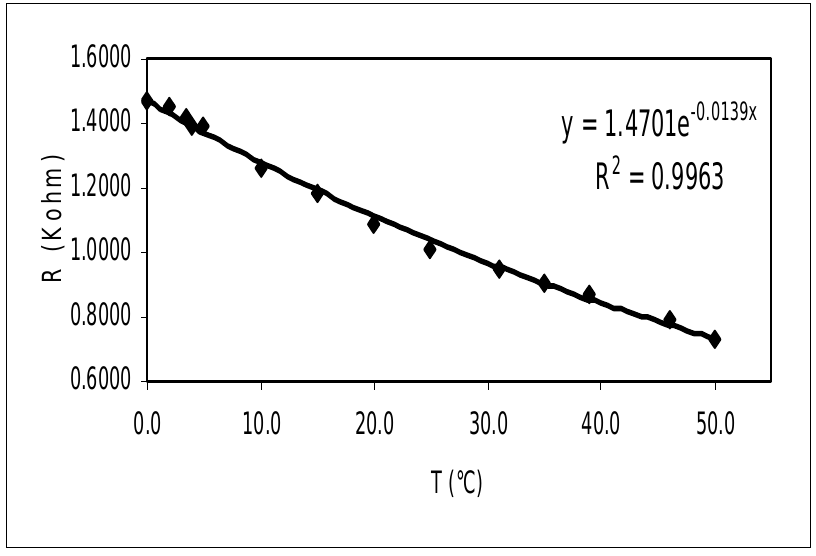
Figure 2. Calibration. Outgoing Electric Resistance of the Thermistor in function to the Temperature. Figure 2 corresponds to the relation between the outgoing electrical resistance of the thermistor and the temperature obtained in a mercury thermometer of 0.01 °C. It can be observed that there is an exponential correlation between the temperature in °C and the electric resistance recorded in the multimeter with an accuracy of 0.01 Ω , in the calibration range observed of 0 to 50 °C and that permits the observation of temperature variations of 0.001